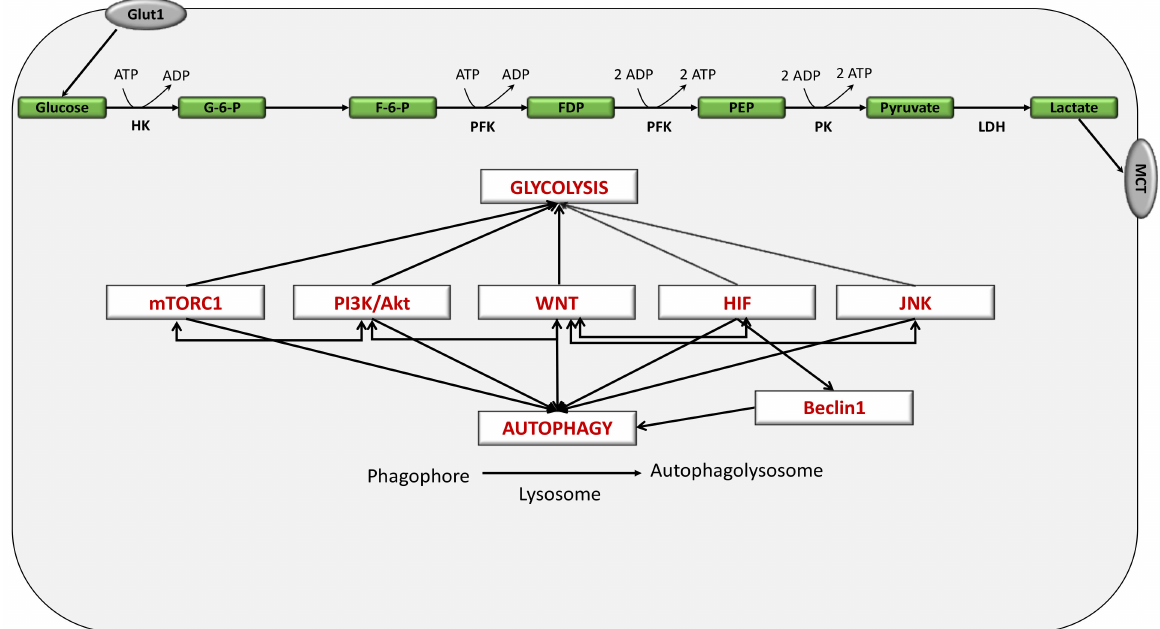
Figure 4. Interplay between the WNT/ β -catenin pathway, aerobic glycolysis and autophagy. The interactions between WNT, PI3K/Akt pathway, mTORC1, HIF and JNK result in stimulating both glycolysis and autophagy, involving several glycolytic enzymes (including, glucose, G6P, F6P, FDP, PEP, pyruvate producing lactate over the cell by MCT). Abbrevi- ations: G-6-P: glucose 6 phosphate, F-6-P: fructose 6 phosphate, FDP: fructose diphosphate, PFK: phosphofructokinase, PEP: phosphoenolpyruvate, JNK: Jun N-terminal kinase, HIF: hypoxic inducible factor, mTORC1: mechanistic target of rapamycin